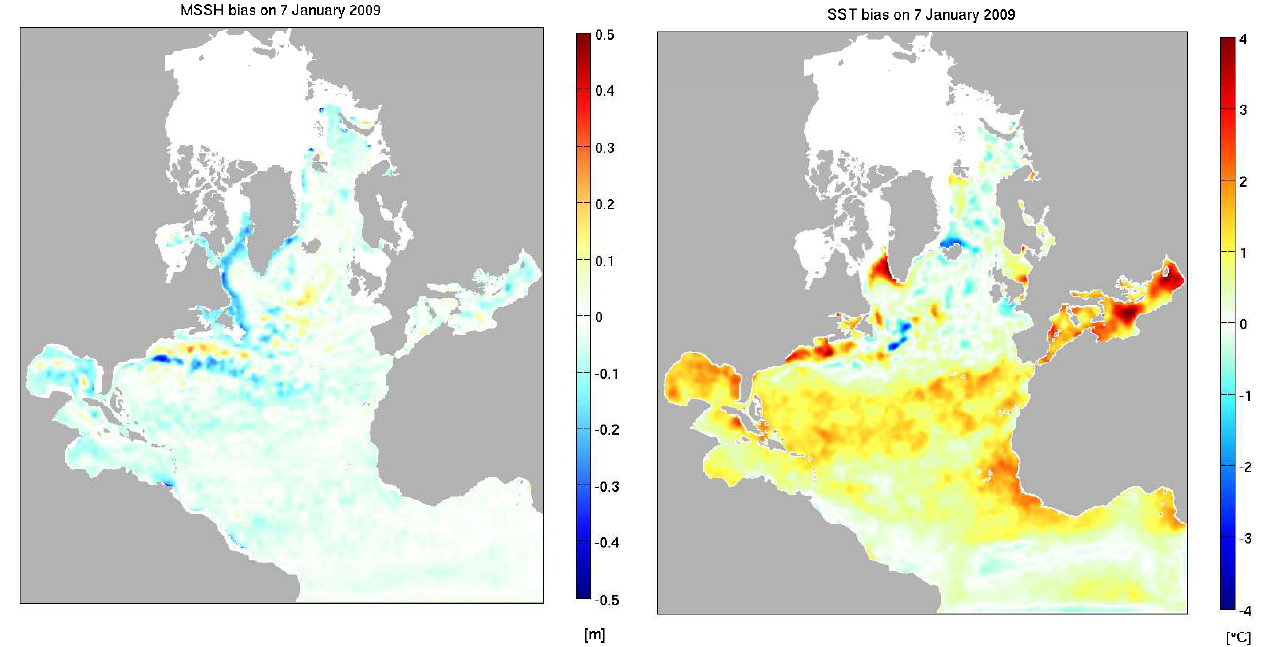
Fig. 8. Estimated MSSH and SST bias fields at the end of the reanalysis (after 10 months of estimation). Regions with no observations available at that time are masked to 0. Positive bias corresponds to a higher model MSSH/SST compared to